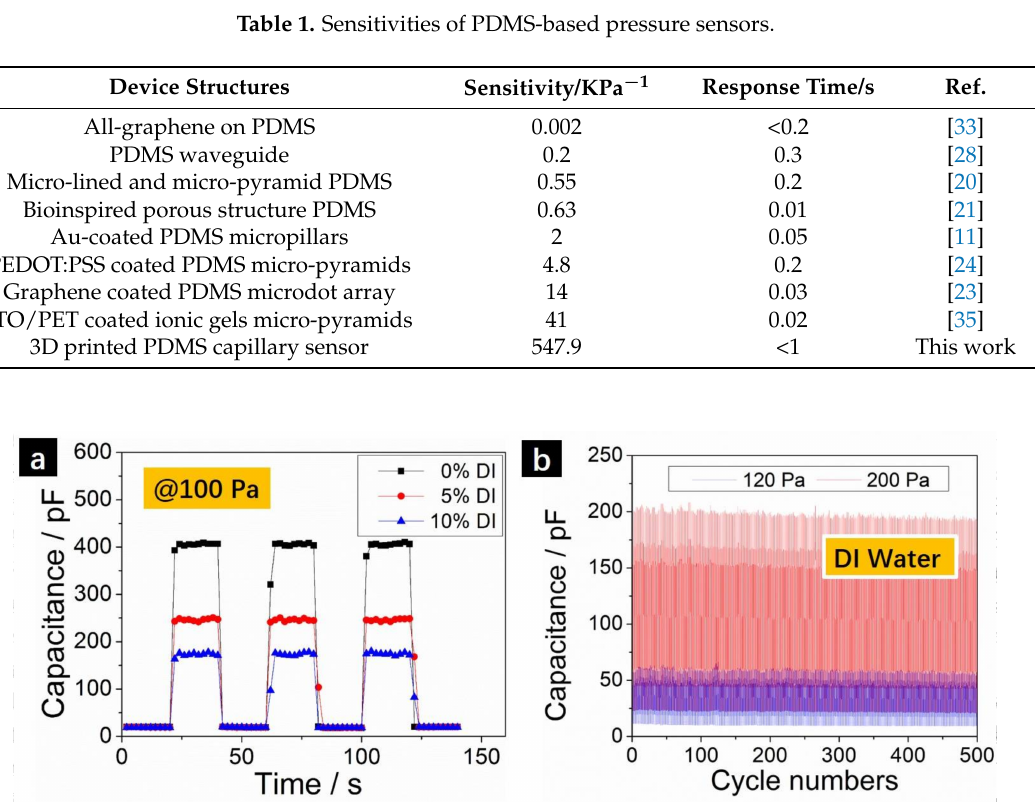
Figure 4. ( a ) The dynamic capacitance changes at 100 Pa using ethanol with 0%, 5% and 10% DI water as liquid medium; ( b ) Device stability testing using DI water as liquid medium at 120 Pa and 200 Pa pressures for 500 pressing cycles. The frequency was fixed at 10 KHz for ( a , b